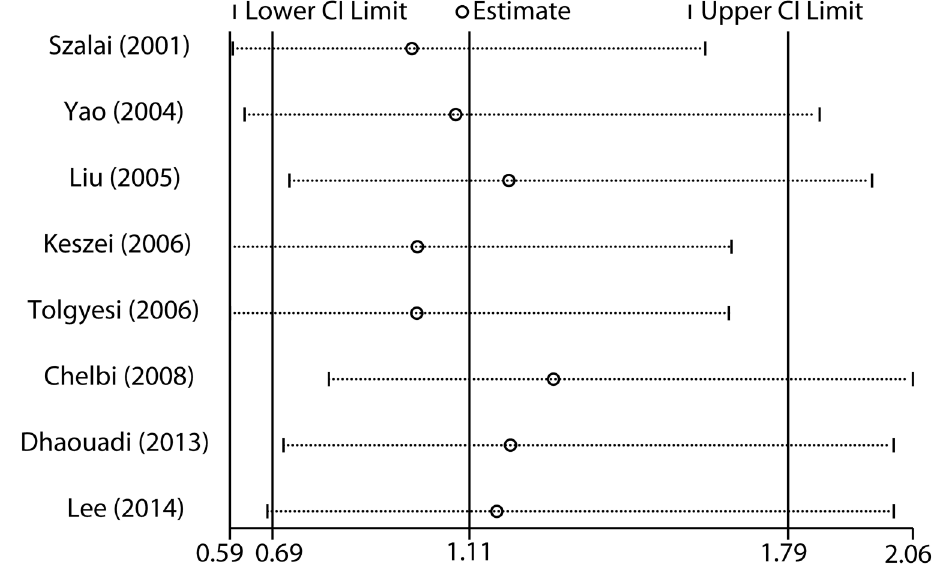
Figure 3. Sensitivity analysis for the MCP-1 -2518 A 4 G polymorphism and asthma susceptibility in the dominant model.